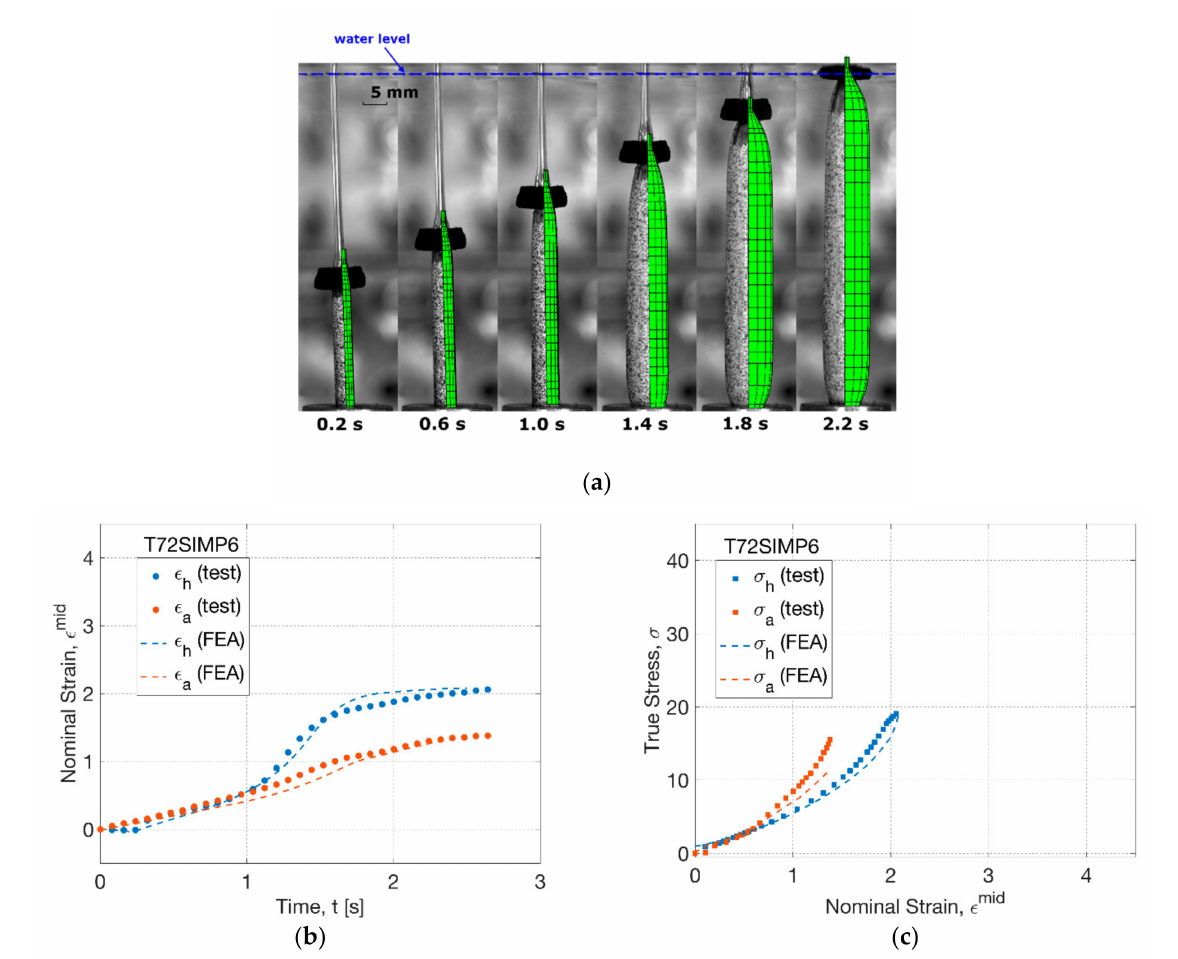
Figure 10. Comparison of results from FEA simulation and blowing test (T72SIMP6): ( a ) shape evolution, ( b ) strain history, ( c ) stress–strain